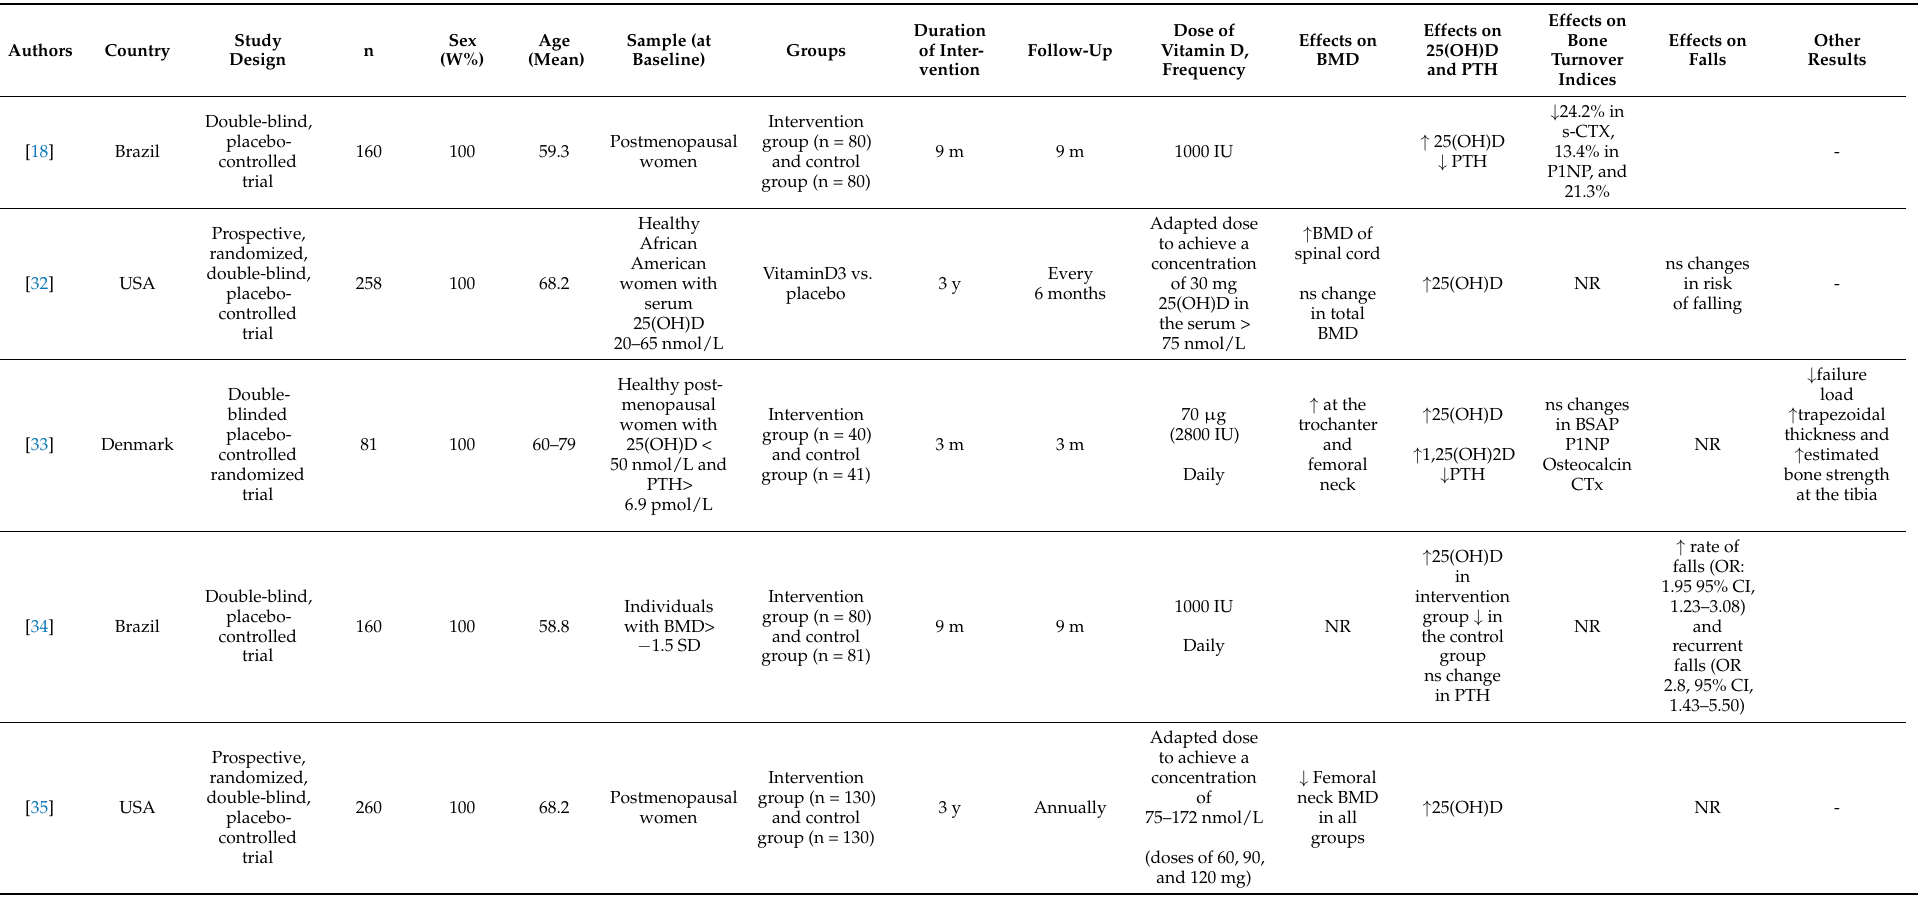
Table 1. Characteristics of included randomized controlled trials with Vitamin D